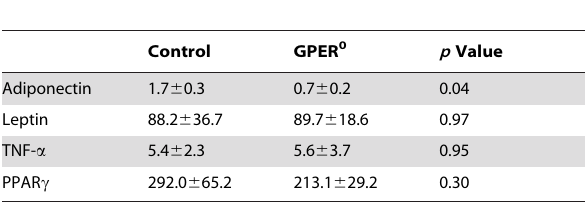
Table 1. Quantitative measurements of adipocyte-related gene expression in aortic perivascular adipose from GPER 0 and control mice.